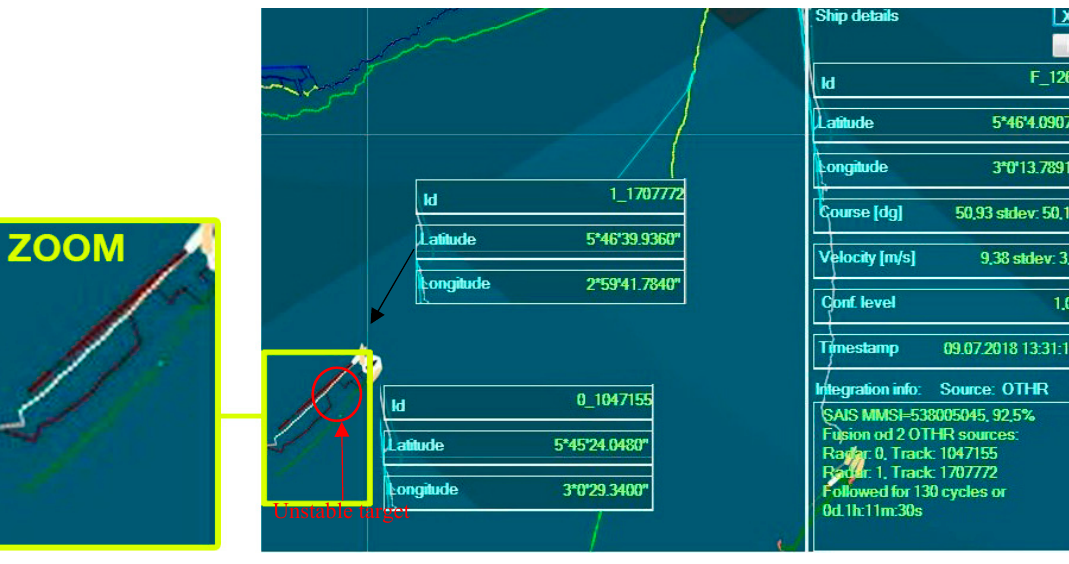
Figure 6. “Tracks” and “Unstable target” (red trace: radar 0 data, green trace: radar 1 data, brown trace: fused track, white trace: AIS data).